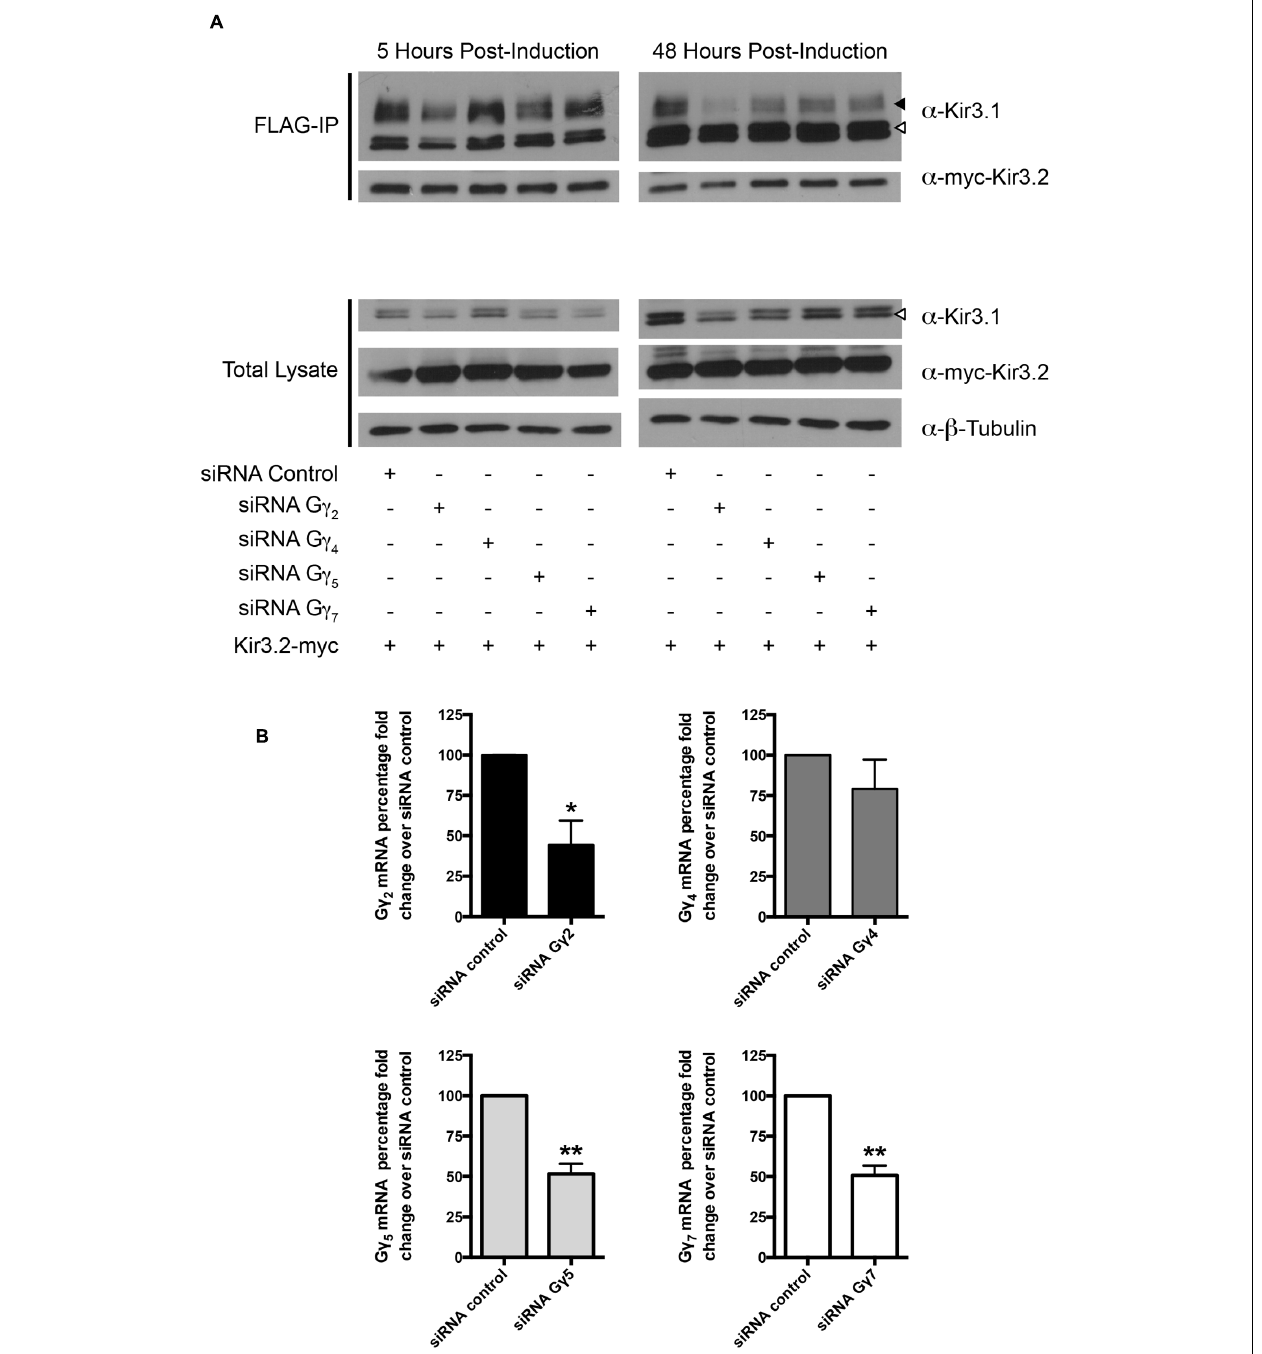
FIGURE 4 | Knockdown of G γ isoforms have differential effect on mature Kir3.1 stability. (A) Flp-In Trex FLAG-Kir3.1 cells were transfected with G γ 2, 4, 5, or 7 targeted siRNA and myc-Kir3.2. The cells were subsequently induced to express FLAG-Kir3.1 with 1 μ g/mL of tetracycline for 30 min followed by 5 or 48 h chase times. Cells were lysed and FLAG-Kir3.1 was immunoprecipitated as described above. Upper panel: samples were analyzed by western blot to detect levels of FLAG-Kir3.1 and myc-Kir3.2. Lower panel: total cell lysates showing expression of Kir3.1, Kir3.2, and β -tubulin (as a loading control). Results are shown from a single experiment. White arrow